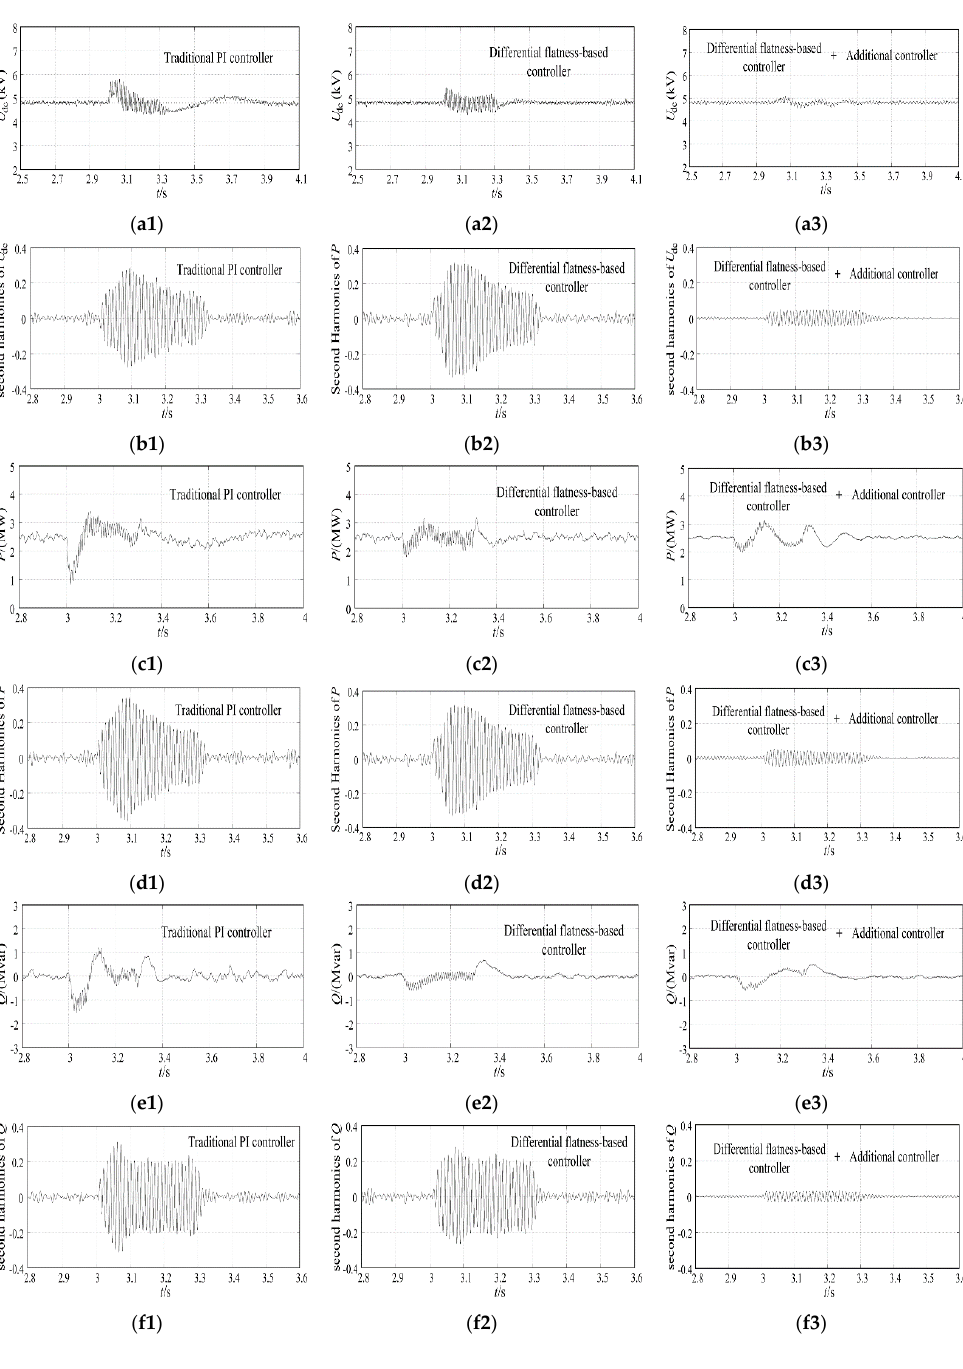
Figure 7. Cont. Figure 7.